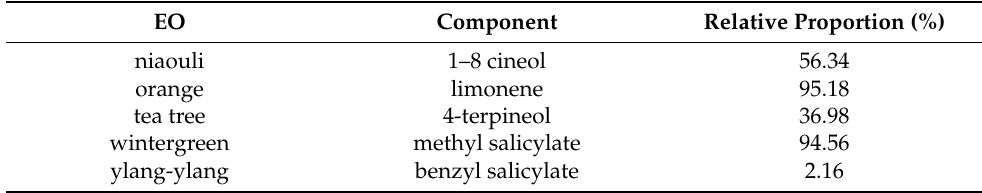
Table 1. Composition analysis of the tested essential oil batches. EO Component Relative Proportion (%) niaouli 56.34 orange limonene 95.18 tea tree 4-terpineol 36.98 wintergreen methyl salicylate 94.56 ylang-ylang benzyl salicylate 2.16